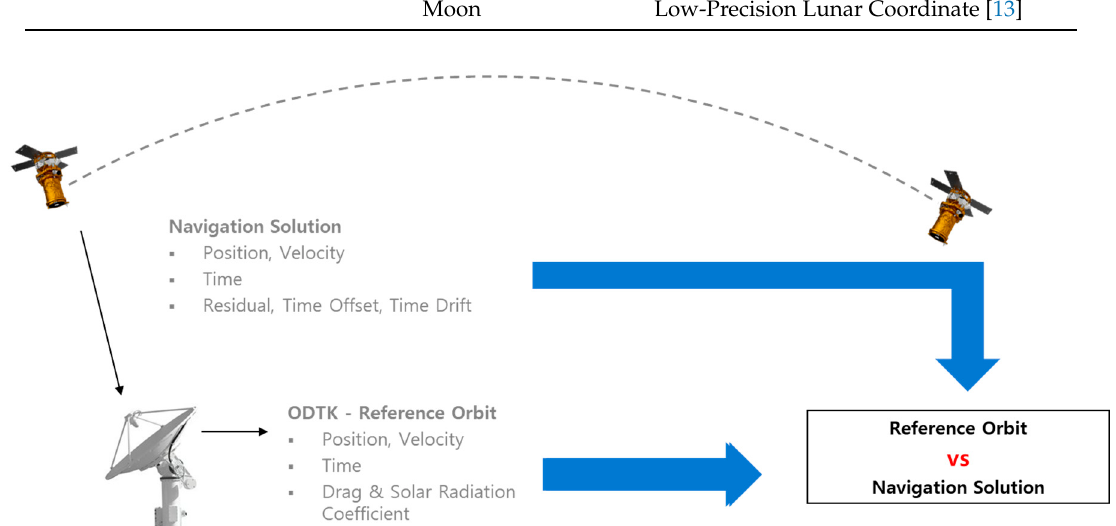
Figure 12. Test configuration using the navigation solution from the DubaiSat-2 satellite to verify the performance of the on-board real-time orbit determination logic of GPS-12. ODTK—Orbit Determination Tool Kit. Table 6. Performance analysis results of on-board real-time orbit determination logic of the GPS-12 on DubaiSat-2 with respect to the reference orbit using Orbit Determination Tool Kit (ODTK).